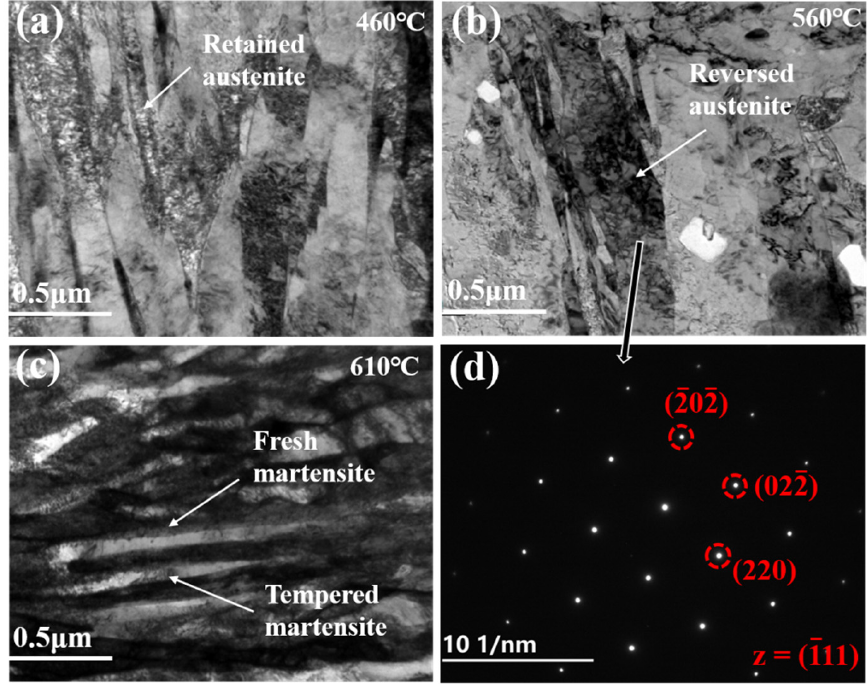
Figure 8. TEM images of the Fe-9Ni-2Cu steel at different tempering temperatures. ( a ) 460 °C; ( b ) 560 °C; ( c ) 610 °C; ( d ) diffraction spot of 560 °C.